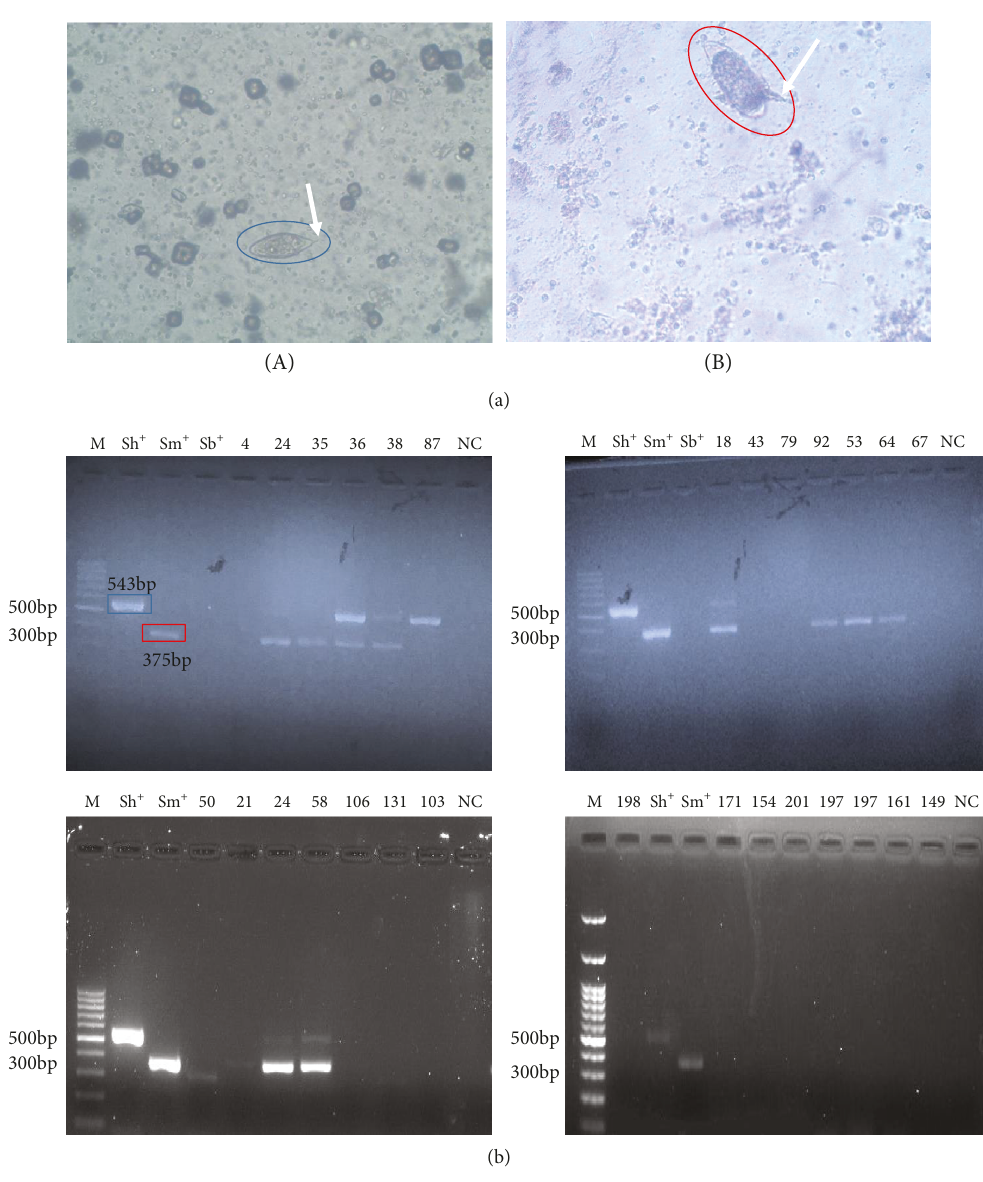
Figure 1: (a) Schistosoma eggs in urine of infected participants: (A) S. haematobium egg (terminal spine indicated with arrow) and (B) S. mansoni egg (lateral spine indicated with arrow). Eggs were visualized under an Olympus CX12 compound microscope (magni fi cation × 20). (b) Ampli fi cation of the partial COX1 gene of Schistosoma spp. Lane M =100bp molecular weight marker; lane Sh + = S . haematobium DNA (positive) control; lane Sm + = S. mansoni DNA (positive) control; lane Sb + = S. bovis DNA (positive) control; lane NC =negative control (nuclease-free water). Numbered lanes are DNA from participants ’ urine